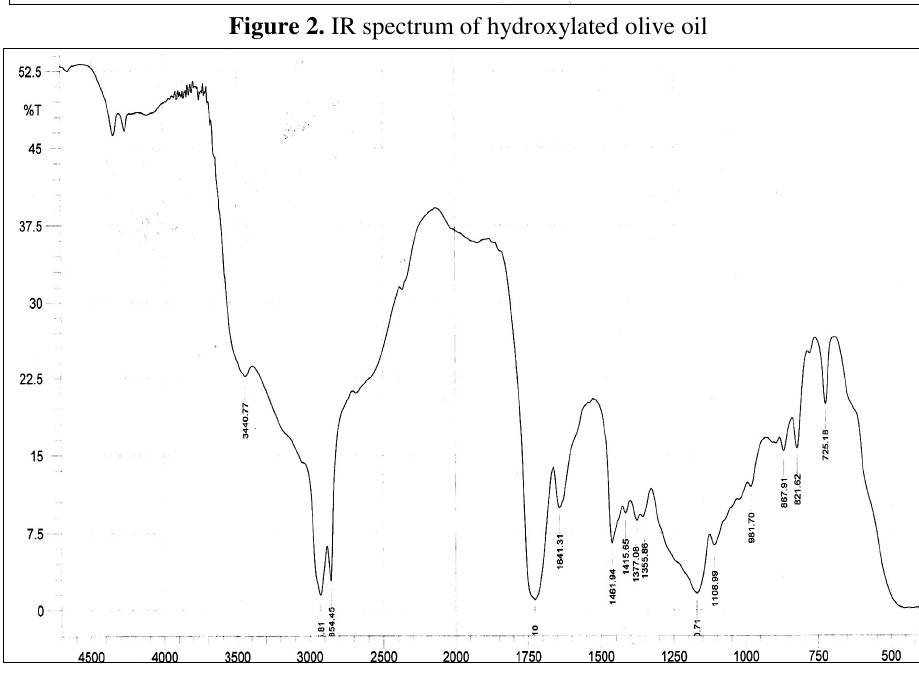
Figure 3. IR spectrum of o -PTF resin olive